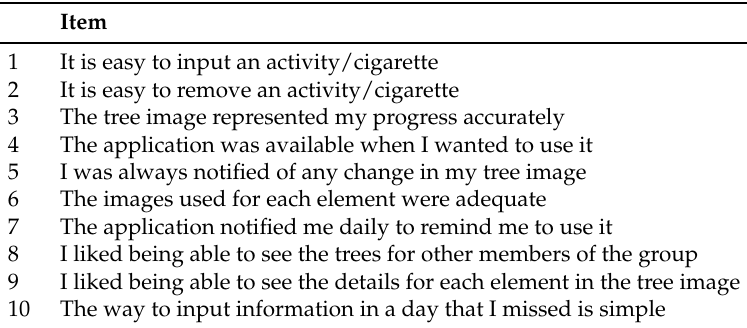
Table 1. Evitapp